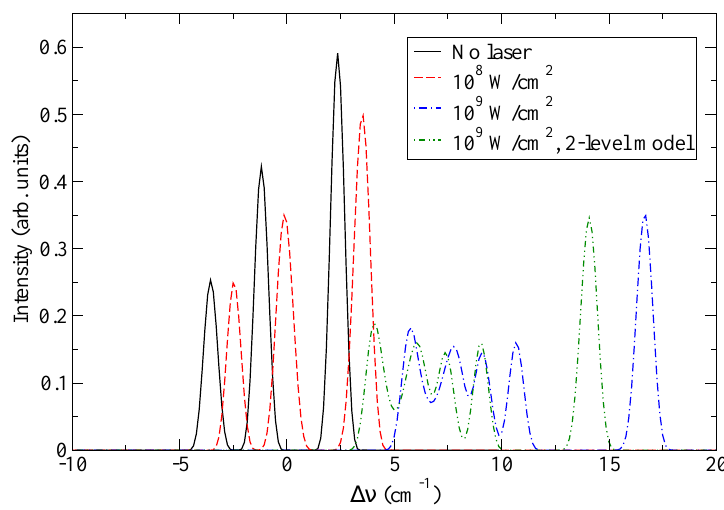
Figure 2. Effect of the nearly resonant laser field on the lineshape. A 805-nm laser radiation (as in [5]) is assumed. All spectra are area-normalized.